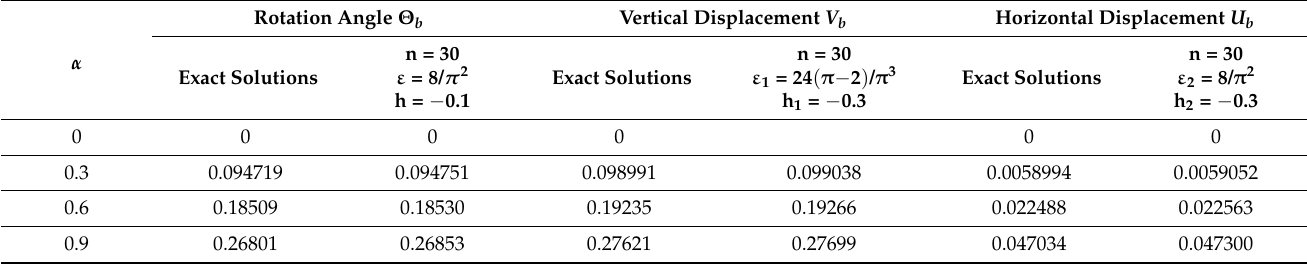
Table A1. 30th-order numerical solutions Θ solutions Θ b , V b and U b